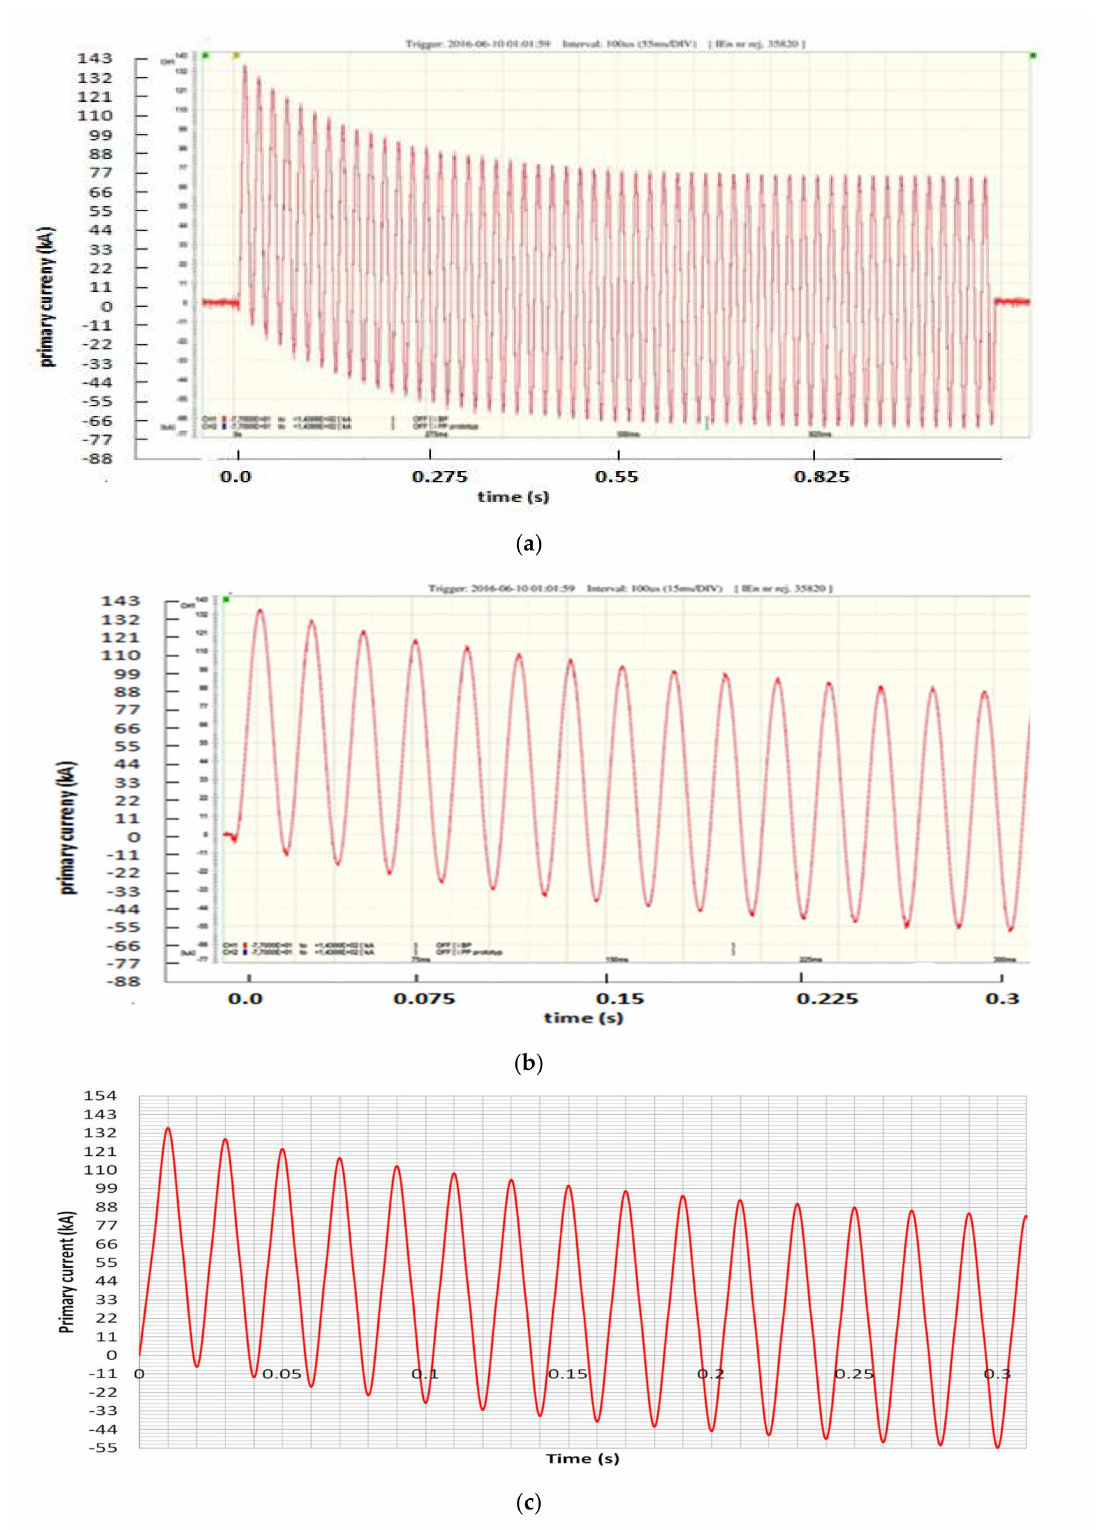
Figure 6. The waveform of the primary short-circuit current with the time constant T p = 190 ms, K ssc = 2.76, and the load R = 0.88 Ω during the tests: the course of the entire test ( a ), the course of the first 16 current peaks ( b ), and the calculations ( c ) i p = − 69.4